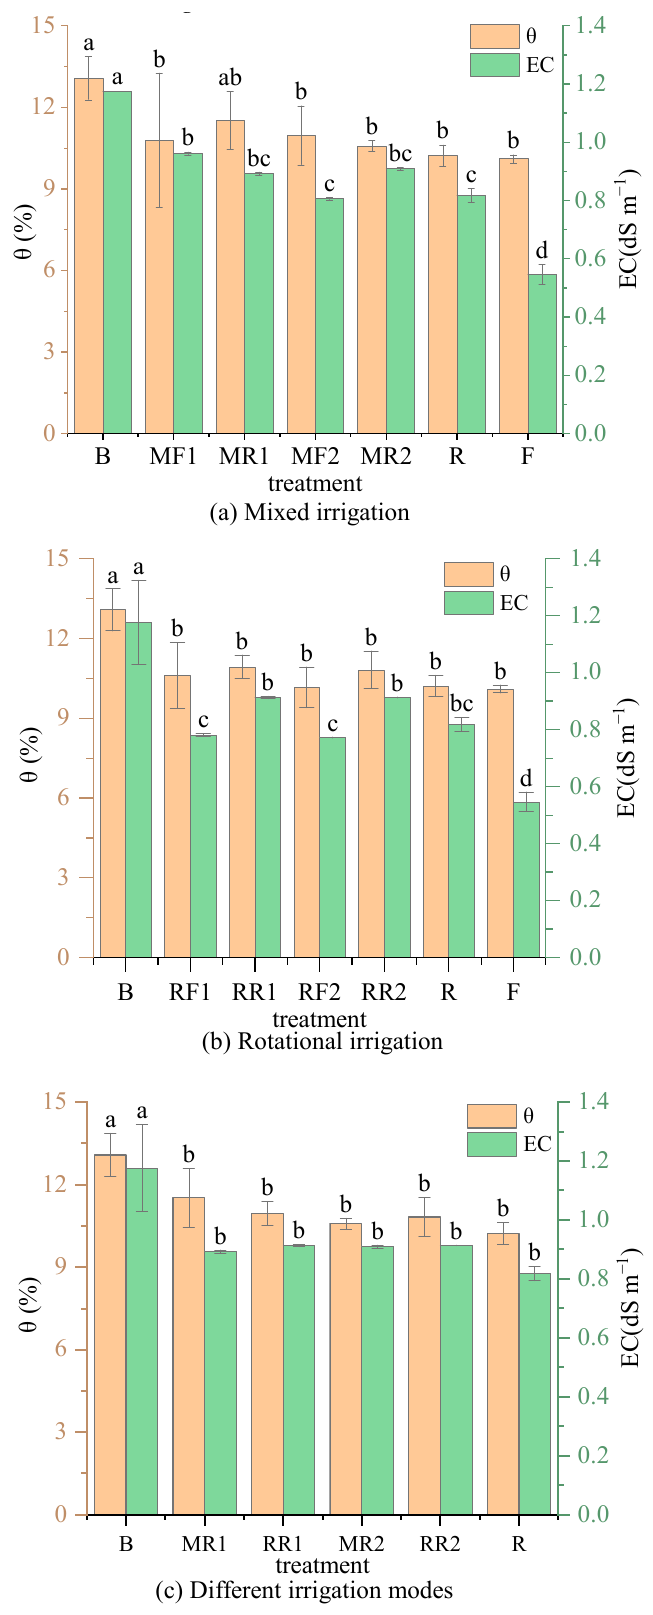
Figure 1. Variations in soil water and salt content under different irrigation scenarios. Note: different lowercase letters on the bars represent the significant differences at the level of 0.05.